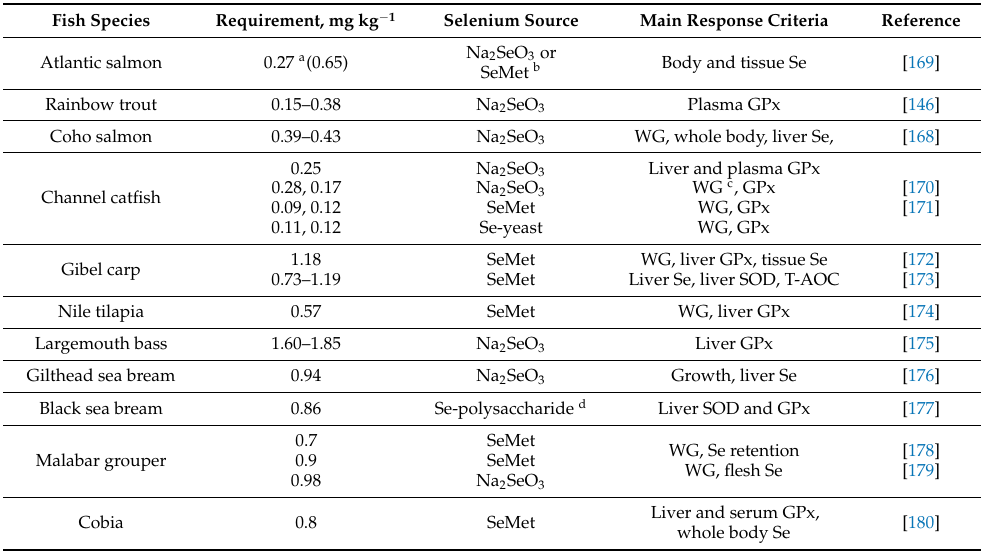
Table 3. Selenium requirements of certain